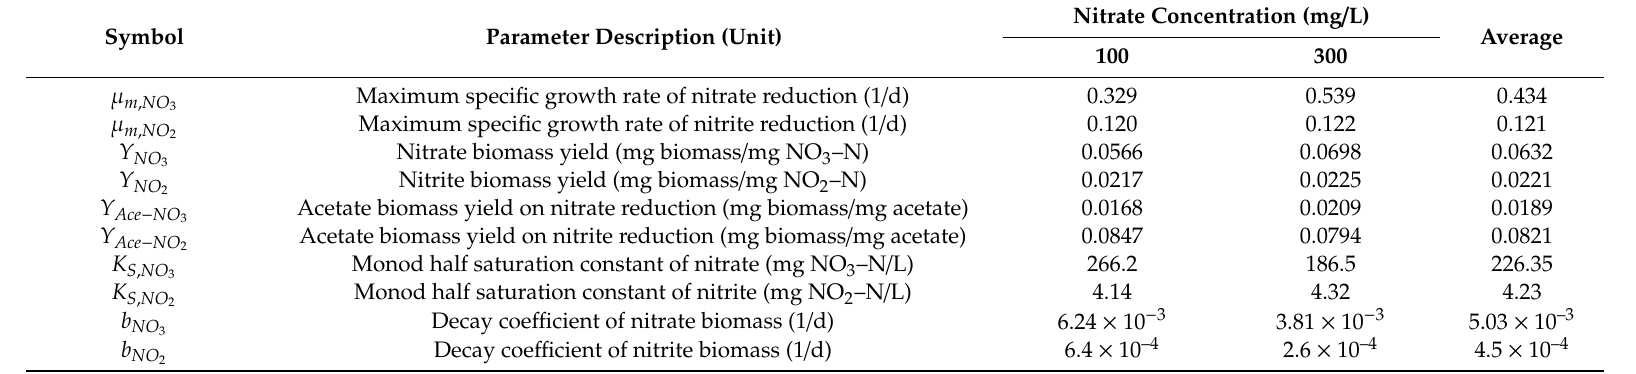
Table 1. Biokinetic parameters based on the batch experimental data and model